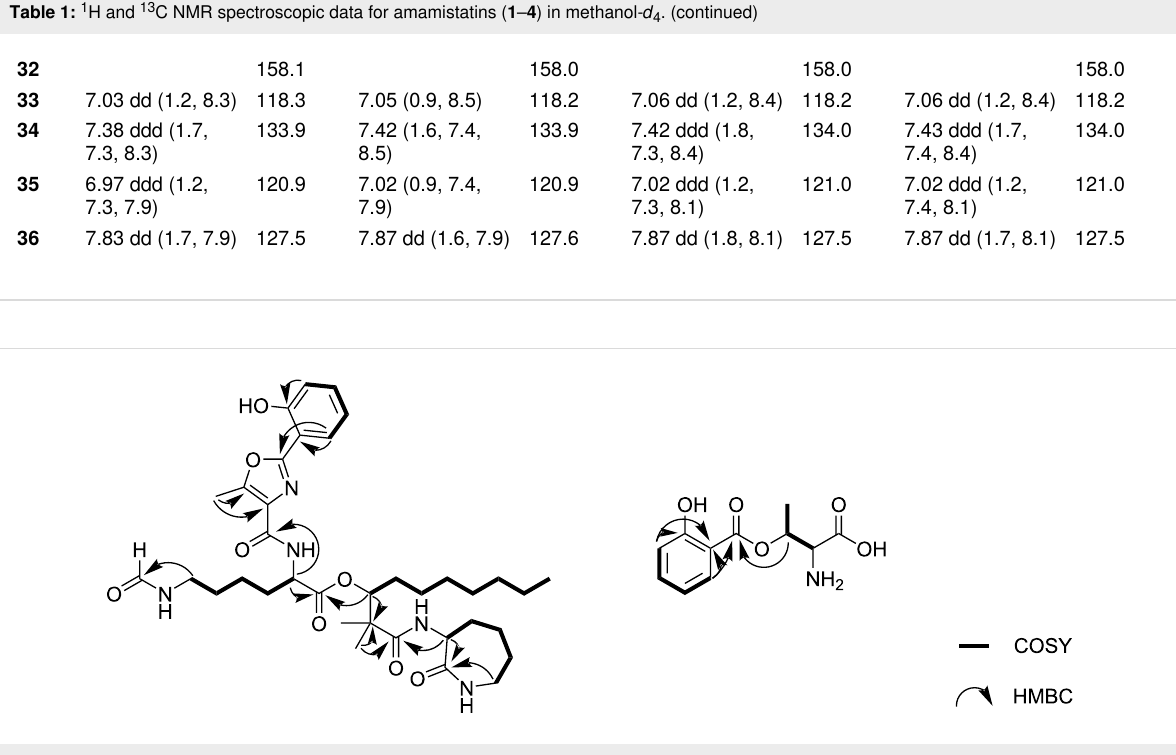
Figure 2: 1 H, 1 H COSY and selected 1 H, 13 C HMBC correlations in compounds 1 and 6 .